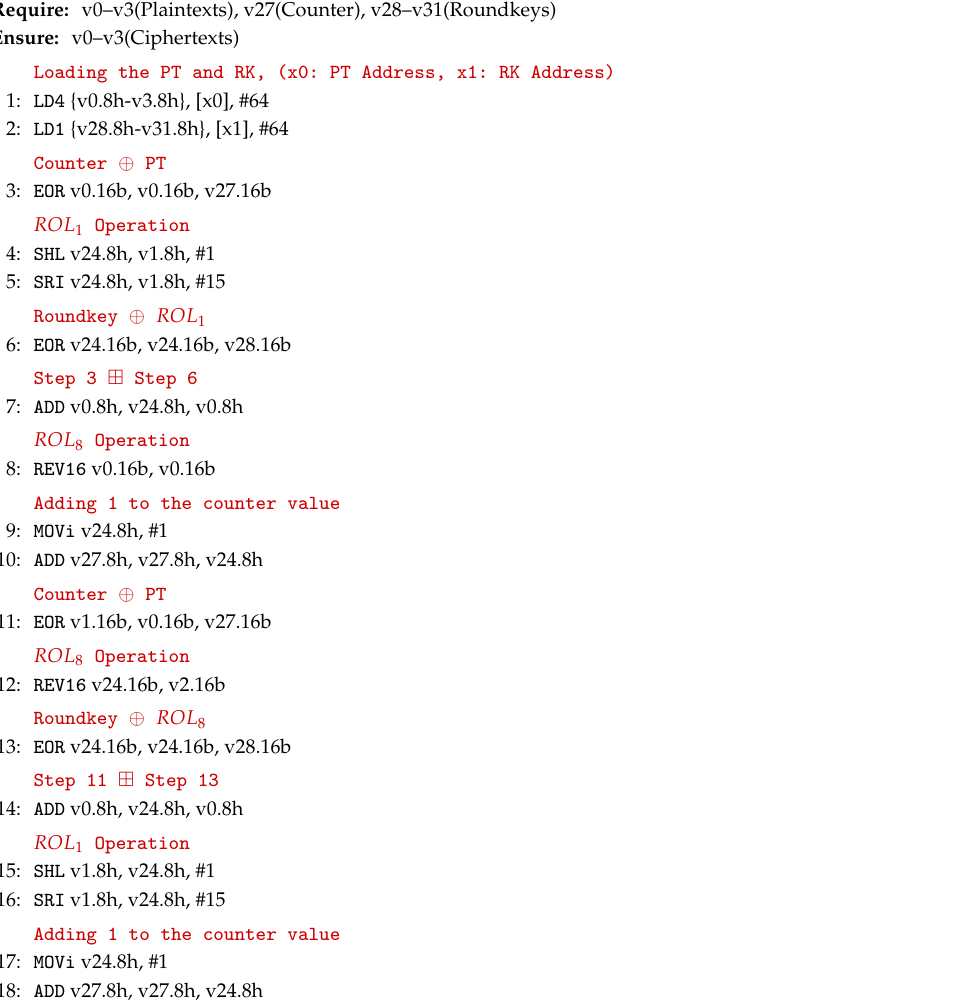
Algorithm 4 Data parallel implementation of revised CHAM-64/128 Round